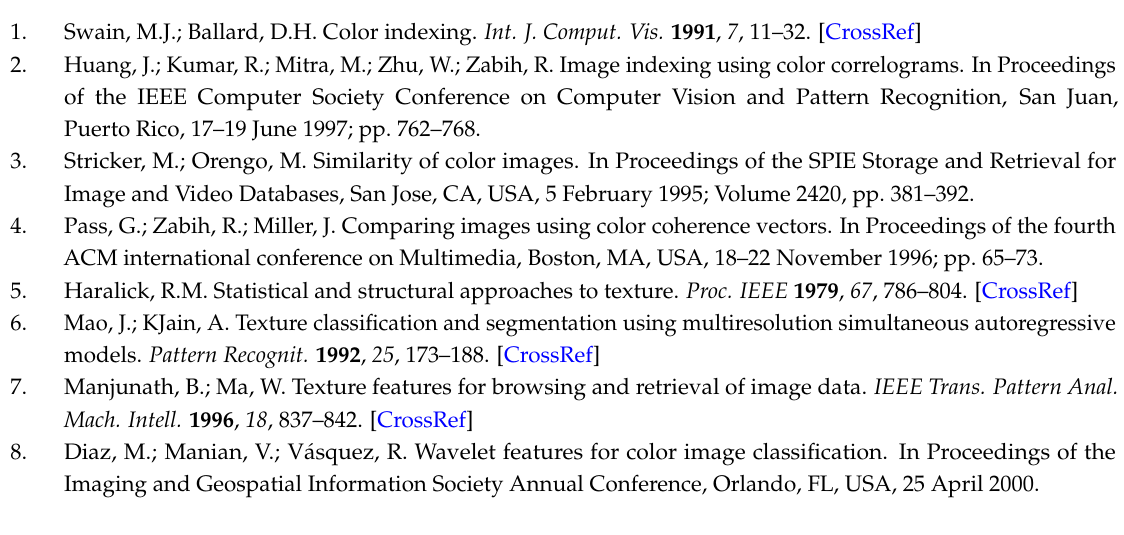
Figure 7 . Examples of the top 10 retrieved images for each class in Corel-1k with